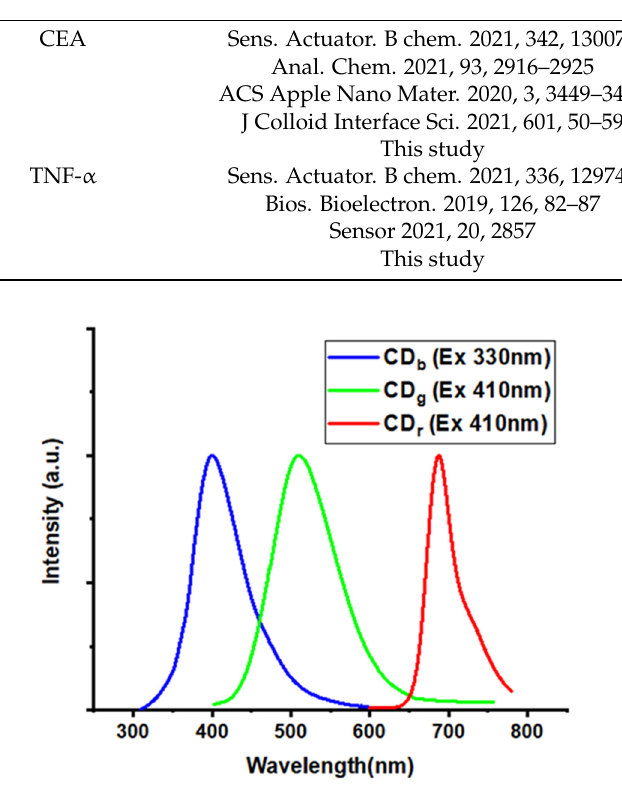
Table 1. Comparison of detection limit and linear range for CEA and TNF- α . Figure 2. ( a ) Changes in the emission wavelengths of the maximal intensity of the three types of CD s (1 mg mL − 1 in PBS); ( b ) ultraviolet-visibleabsorption spectra of the three types of CD s (0.1 mg mL − 1 in PBS).